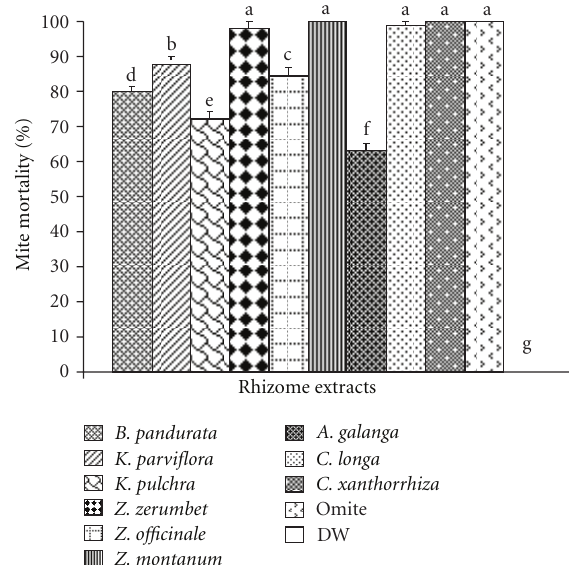
Figure 1: The mortality rates of adult female Luciaphorus sp. after being treated with 5% rhizome extracts at 3 days after application. Bars (mean ± SE) with same letter(s) are not significantly di ff erent as determined by LSD test at P < 0 .